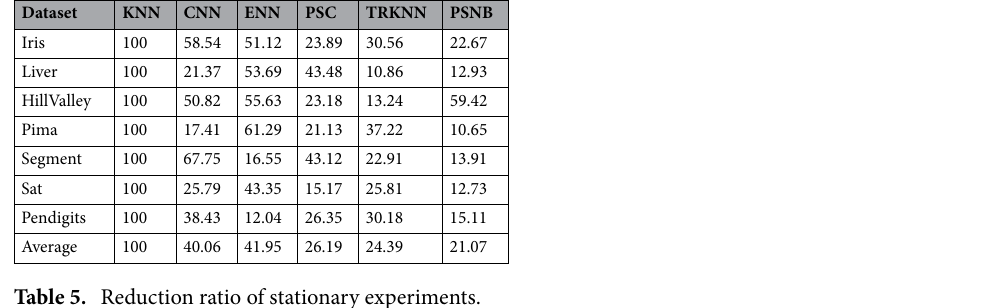
Table 5. Reduction ratio of stationary